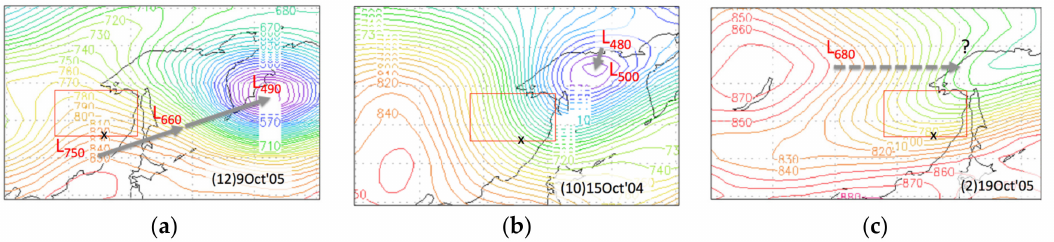
Figure 9. Low-pressure systems associated with October-Fire. ( a ) (12)9Oct (cid:48) 05; ( b ) (10)15Oct (cid:48) 04; ( c ) (2)19Oct (cid:48) 05.